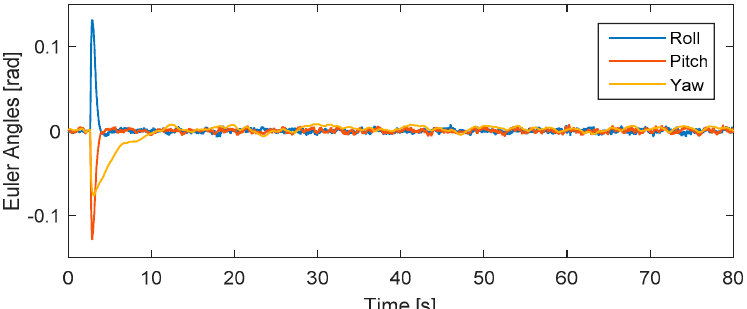
Figure 5. The attitude angles.